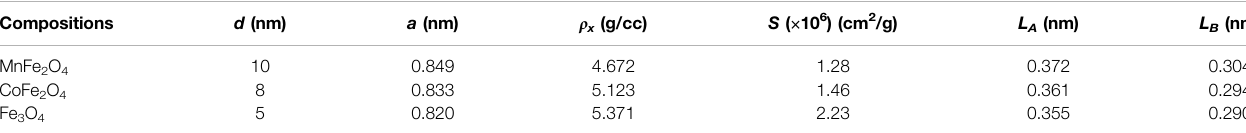
TABLE 1 | Particle size ( d ), lattice parameter ( a ), X-ray density ( ρ x ), speci fi c surface area ( S ), hopping lengths for the tetrahedral ( L A ) and octahedral sites ( L B ) of MnFe 2 O 4 , CoFe Compositions